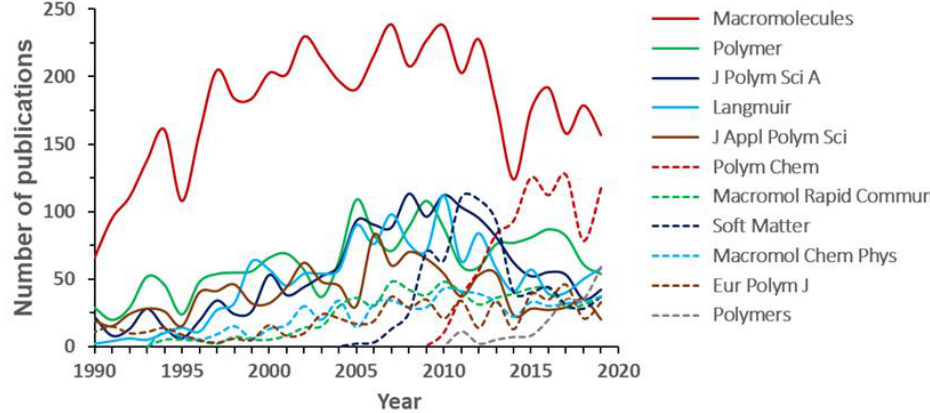
Figure 8. Trend for the main journals (publications between 1990 and 2019).